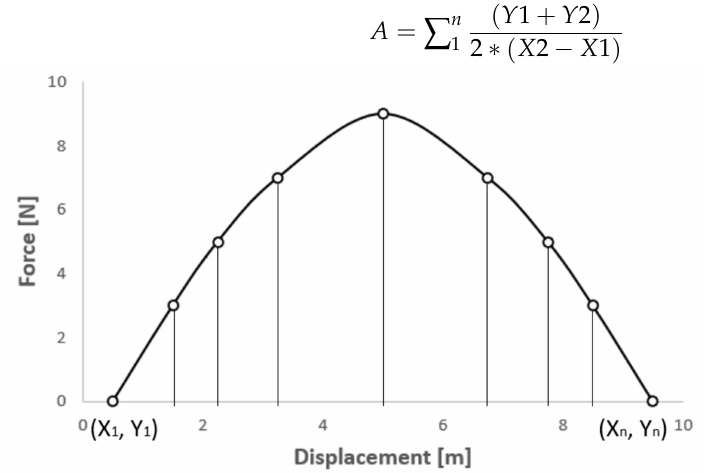
Figure 2. Schematic representation of a pull-off F/s